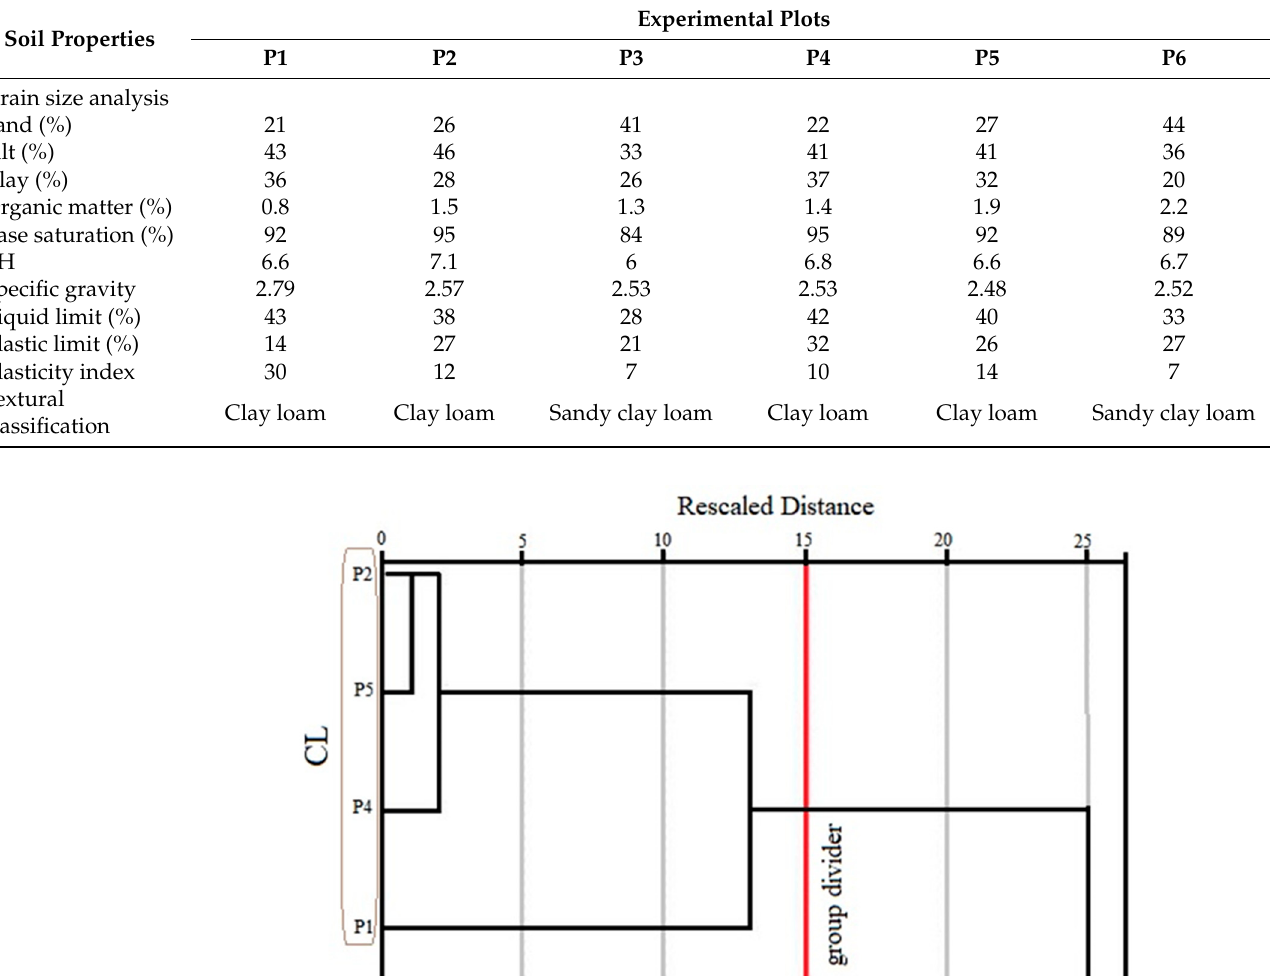
Table 2. Soil properties of the experimental plots.